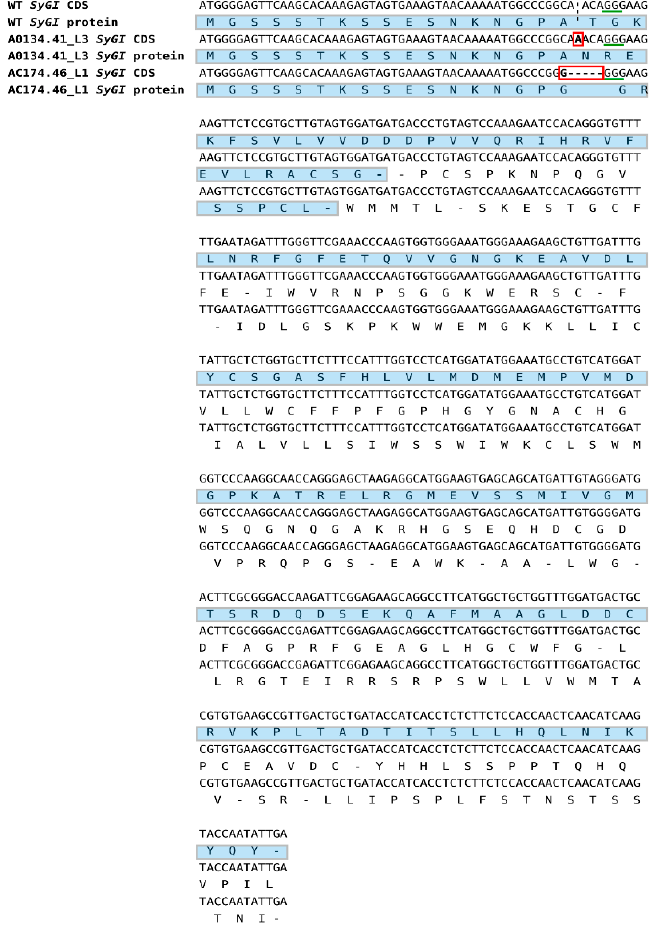
Figure 6. Alignment of coding sequences (CDS) of Wild-Type SyGI (WT) and edited SyGI in the A0134.41_L3 and Ac174.46_L1 lines. PAM sequence is underlined in green. In the WT SyGI CDS, the predicted cleavage site is underlined by a stuttered line, and it has been found three bases upstream of the PAM sequence. The insertion of a single A in plant line A0134.41_L3 and the deletion of five bases plus the insertion of a single G in plant line Ac174.46_L1 are underlined in red. Protein translation is shown; in both edited lines, the modifications cause a reading frame shift, with a consequent formation of a premature stop codon. Plants 2020 , 9 , x FOR PEER REVIEW